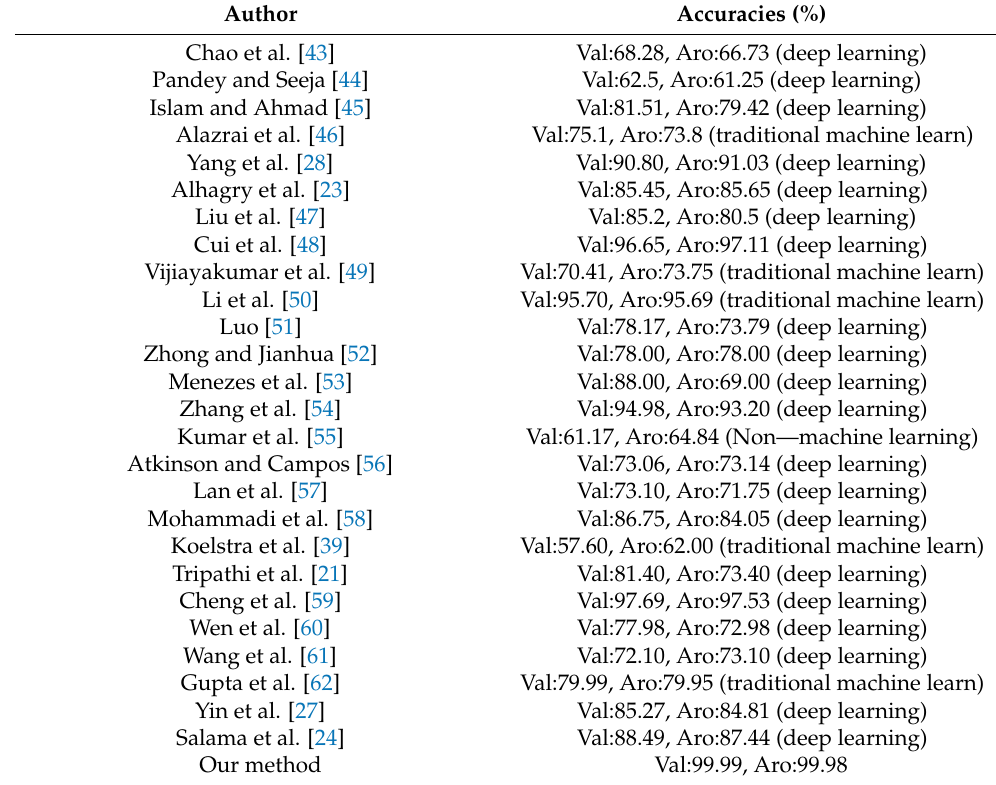
Table 3. Comparison with other studies that used the DEAP dataset.